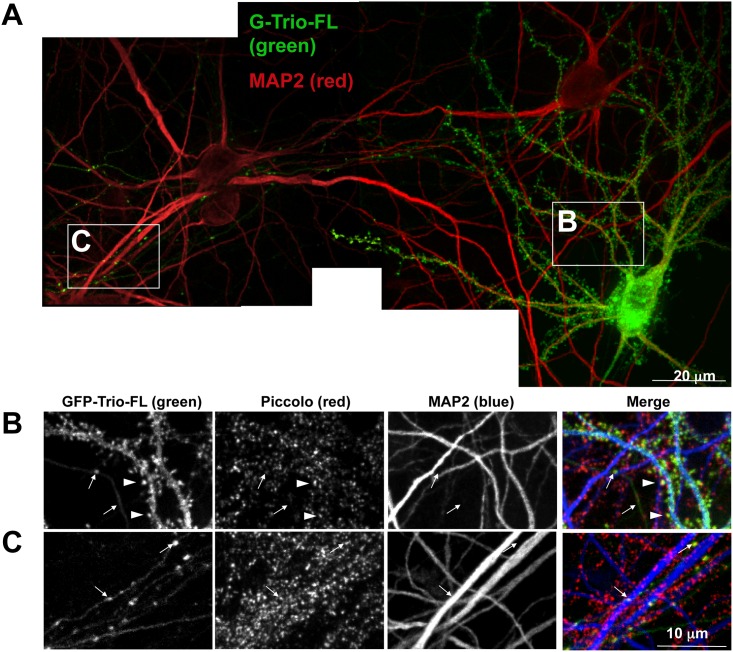
GFP-Trio-FL targets to dendritic spines and presynaptic terminals.(A) Montage of several images of a neuron transfected with GFP-Trio-FL (green) growing near untransfected neurons immunostained with antibodies against the dendritic microtubule associated protein MAP2 (red). (B and C) Higher magnification images from panel A with GFP-Trio-FL (green), Piccolo (red), and MAP2 (blue), illustrating that GFP-Trio-FL targeted to dendritic shafts and spines (arrowheads panel B) as well as to MAP2-negative axons (arrows in panel B). Furthermore, GFP-Trio-FL had a distinctly punctate presynaptic localization in axons as demonstrated by the colocalization of these GFP-Trio-FL puncta (arrows in panel C) with Piccolo positive puncta (red) situated along dendrites of untransfected neurons (C).